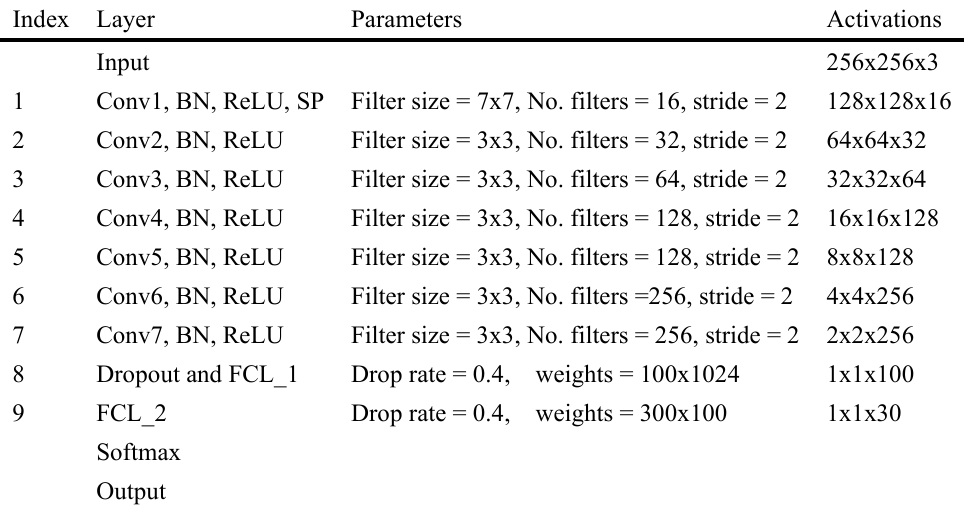
Table 2. Structure of proposed CNN